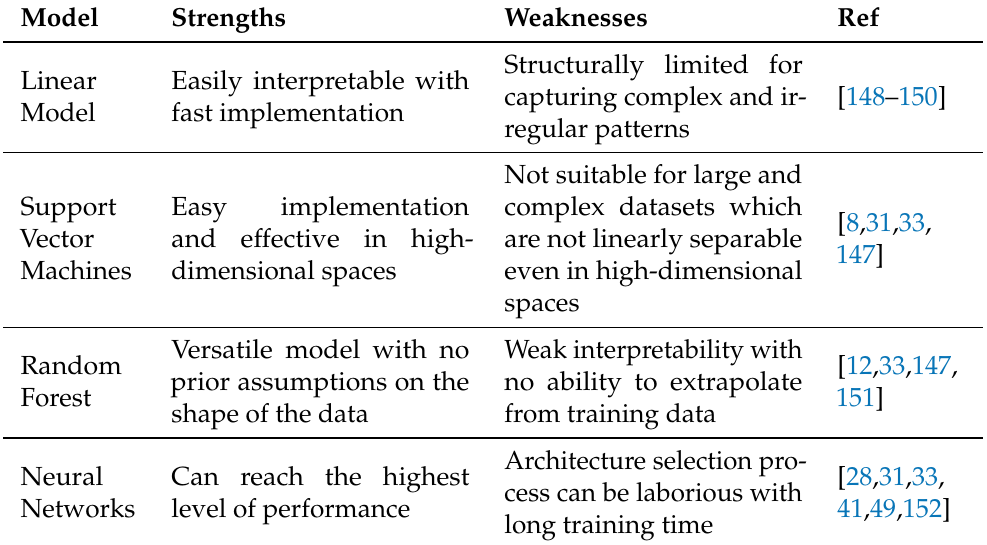
Table 4. Machine learning models for EV